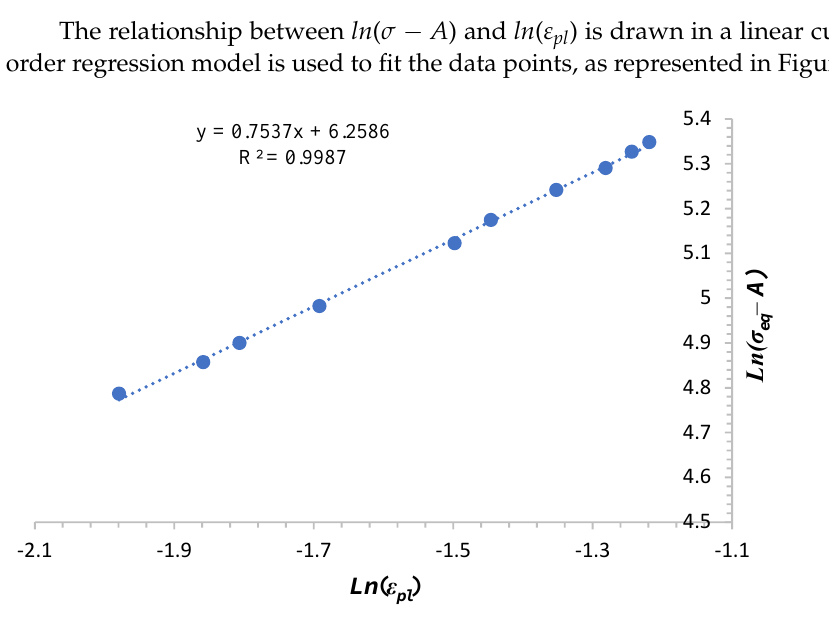
Figure 3. Logarithm curve of the Johnson–Cook hardening model.